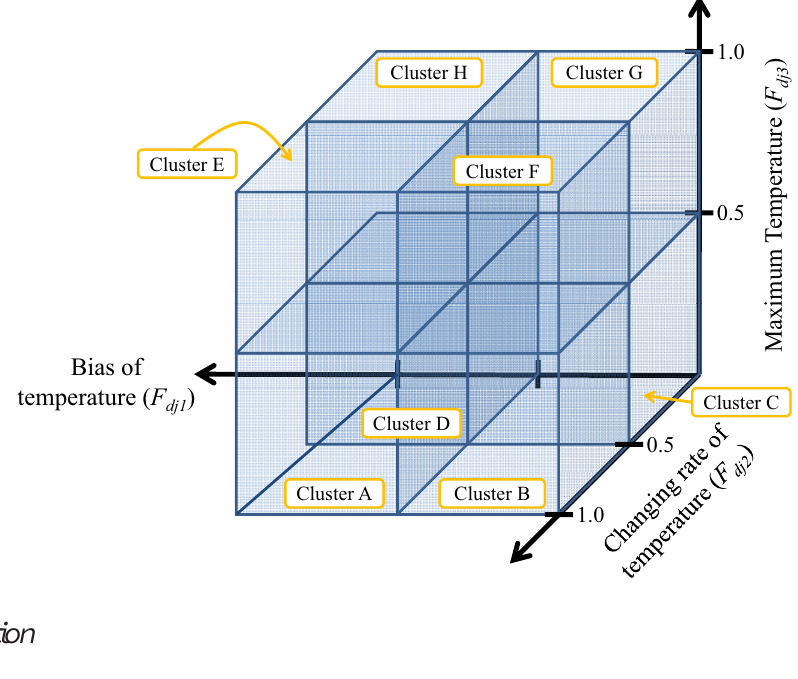
Figure 6. An illustration of eight clusters based on three normalized